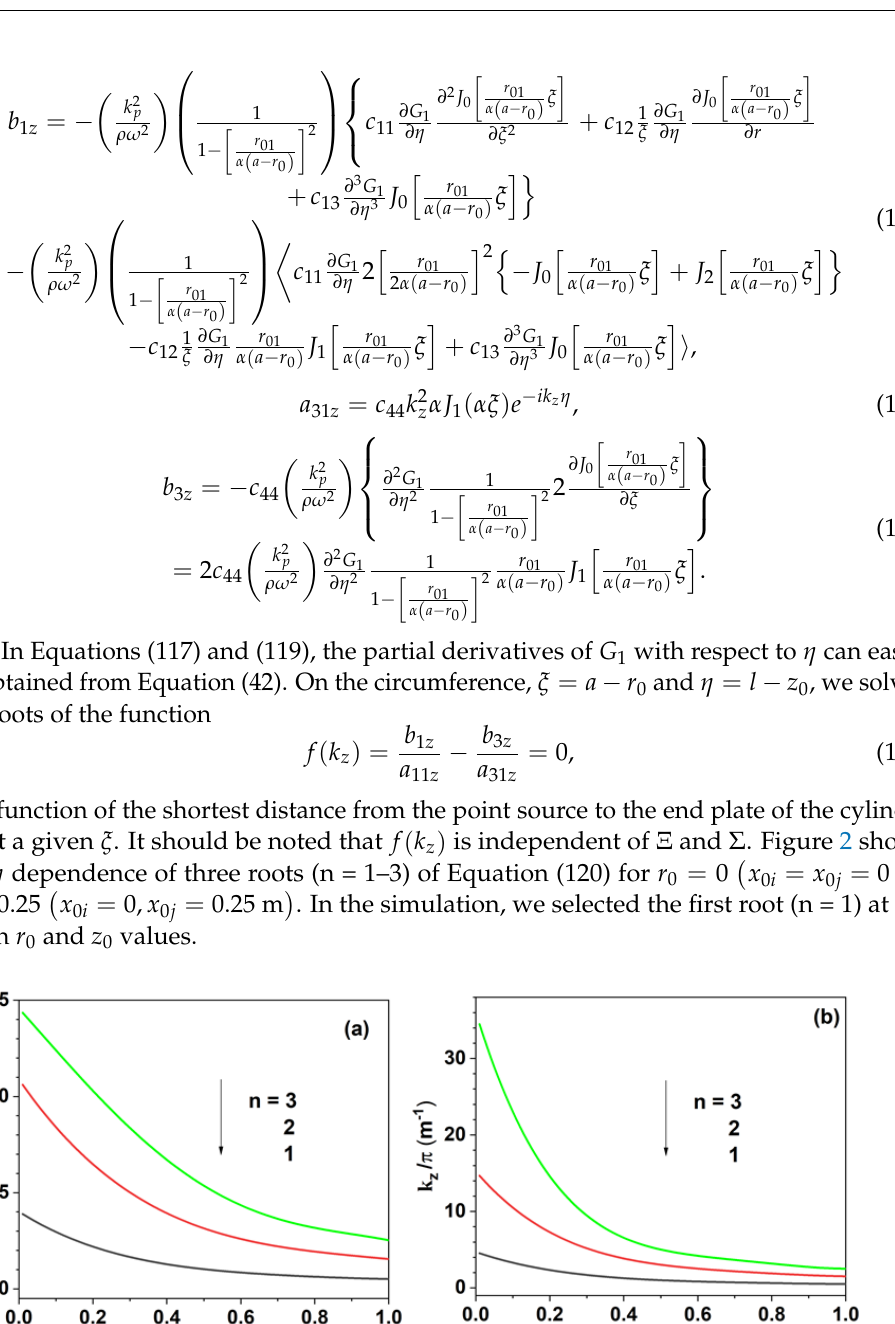
Figure 3. Effect of the b parameter of the point source on the envelopes of the simulated 𝑢 𝑟𝑗 wave- forms: (1) 6 × 10 4 , (2) 8 × 10 4 , (3) 1 × 10 5 , (4) 2 × 10 5 , and (5) 4 × 10 5 . In the simulation two positions of the point source of 1 N were considered, with co- ordinates of (0 m, 0 m, 1 m) and (0 m, 0.25 m, 1 m). Figure 4a shows the displacements, and their wave properties, at the (0.5 m, 45°, 1 m) position, generated by the 𝑃 𝑓 point source located at the center of the cylinder (0 m, 0 m, 1 m). The P j excitation produces an axial displacement that is stronger than the radial and tangential displacements. These displacements result in the P wave being the main wave, with a minor SH wave and very weak SV wave (Figure 4b). As shown in Figure 4c, the displacement features generated by the P z excitation differ significantly from those generated by the P j excitation. For the P j excitation, the maximum values of 𝑢 𝑟𝑗 and 𝑢 𝑧𝑗 at the (0.5 m, 45°, 1 m) position were 0.29 and 0.71 nm, respectively, whereas for the P z excitation, they were 28.1 and 5.0 nm, respectively. The amplitudes of the displacements due to the P z excitation were much stronger than those due to the P j excitation. It should be noted that the P z excitation pro- duces only the P wave (Figure 4d). The angular dependence of the displacement was also calculated (Figure 5). When the point source is located at the center of the circular plane, the angular dependences of 𝑢 𝑟𝑗 , 𝑢 𝑧 𝑗 and 𝑢 𝑡 𝑗 arise from only  and  as defined in Equa- tions (72) and (78), respectively. For P z excitation, the displacements of 𝑢 𝑟𝑧 and 𝑢 𝑧𝑧 are